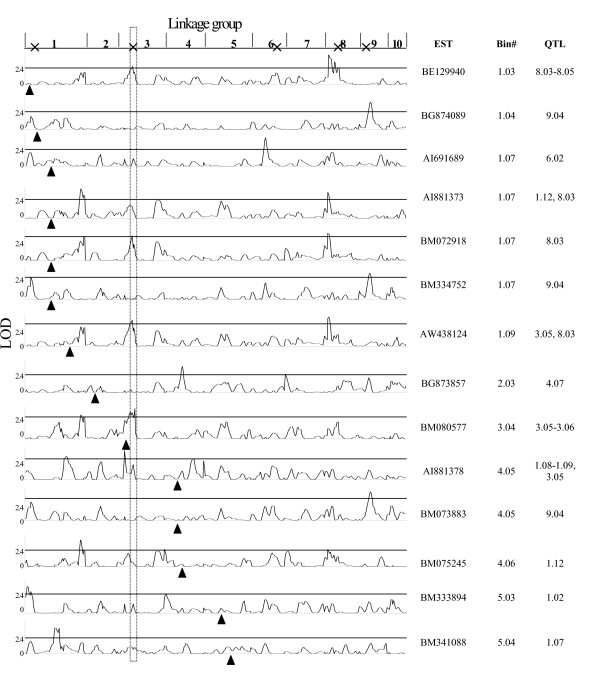
LOD score profiles generated by interval mapping analysis of dNDF and expression levels of 14 ESTs in silico mapped among 89 ESTs resulting in eQTL. The black triangles indicate the in silico mapping position for each EST. EST mapping information was extracted from the Maize GDB [13] and the IDP mapping project [27], according to map bins [3]. The x axis represents ten linkage groups of the Flint × Flint genetic map arranged end-to-end. The middle line represents LOD score threshold 2.4. The "× " indicates five major QTL clusters for cell wall digestibility on bins 1.03, 3.05/06, 6.06, 8.05, and 9.02 [1]. The dashed rectangle shows some eQTLs co-localizing with one major QTL cluster for cell wall digestibility on bin 3.05.